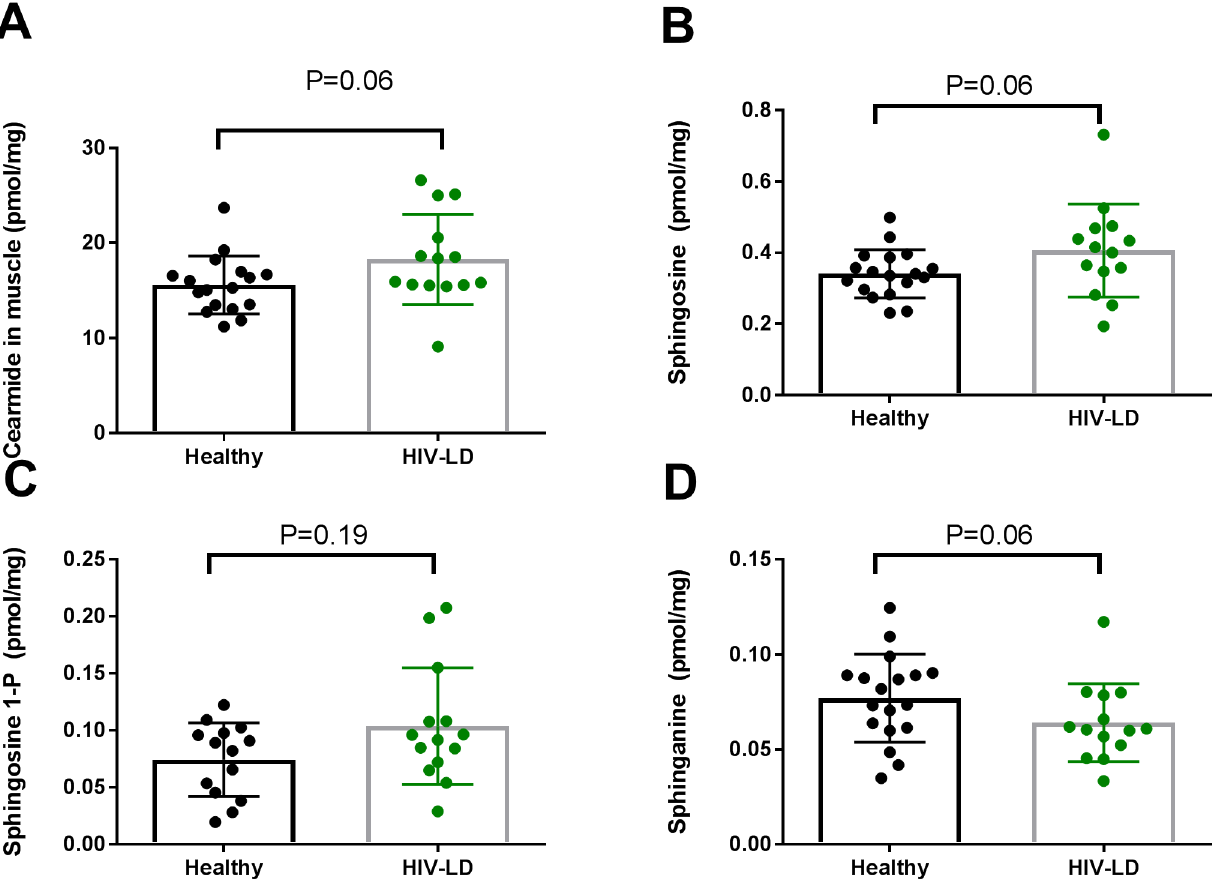
Fig 2. The sphingolipids ceramide and sphingosine tended to be increased in vastus lateralis muscle from patients with HIV-lipodystrophy. In the dot plots data for each subjects are given and the line represent means and SD.